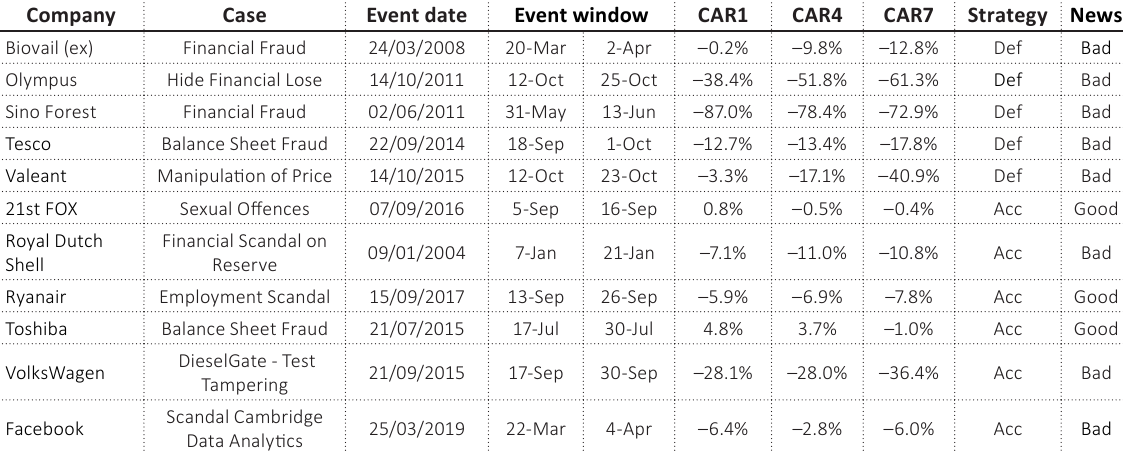
Table A3. Scandals. Shock event descriptions